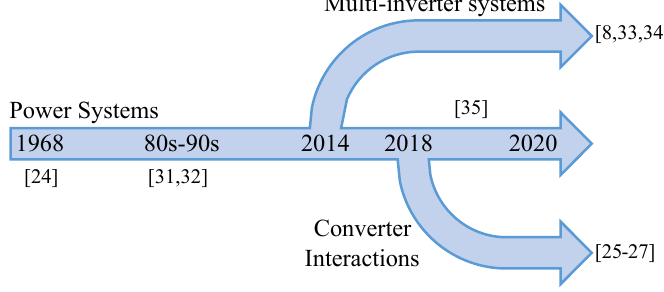
Figure 2. Applications and trends of CCM in time.